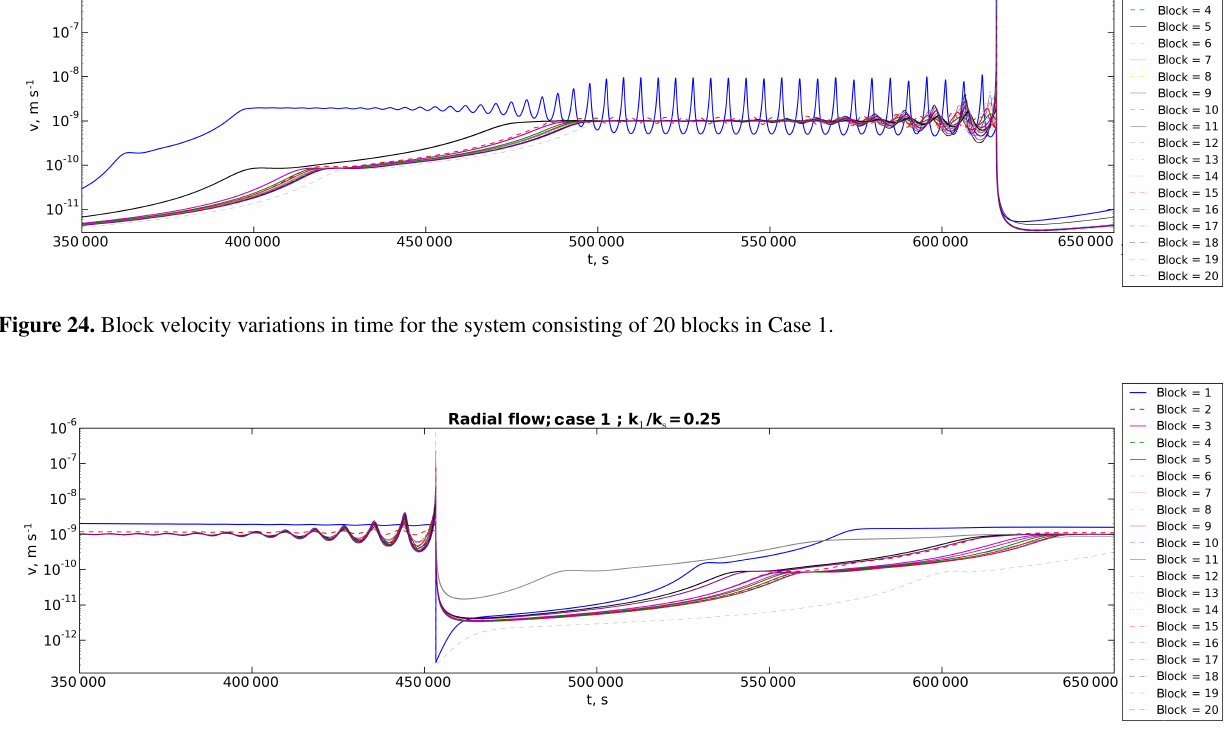
Figure 25. Block velocity variations in time for the system consisting of 20 blocks in Case